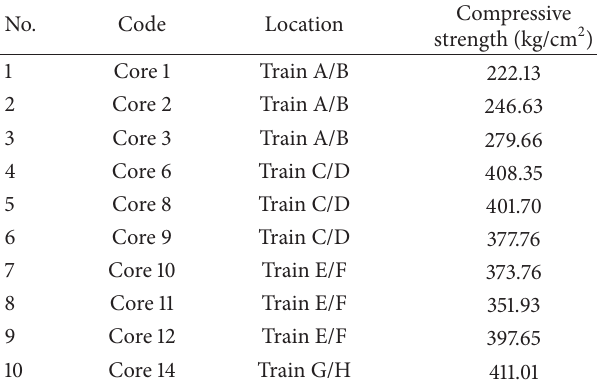
Table 2: Compressive strength of core-drilled